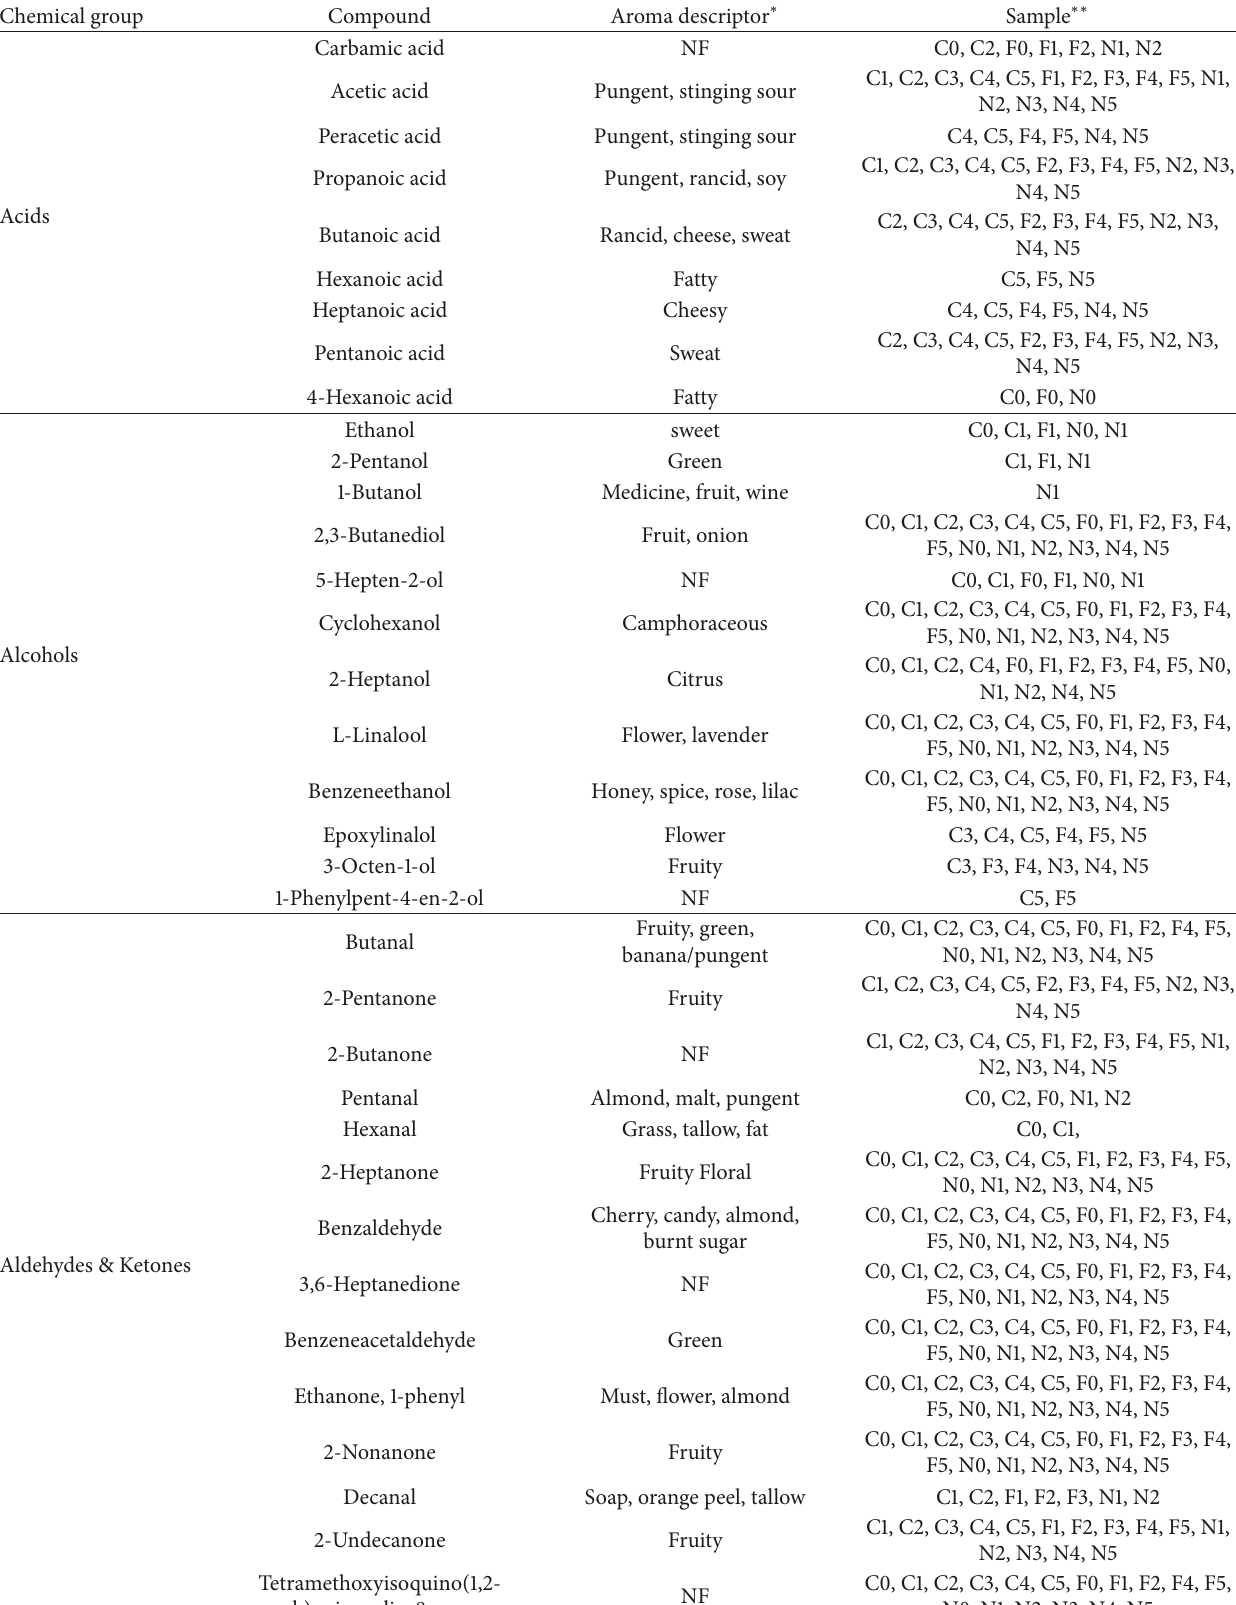
Table 1: Volatile compounds and aroma descriptors found at different sampling